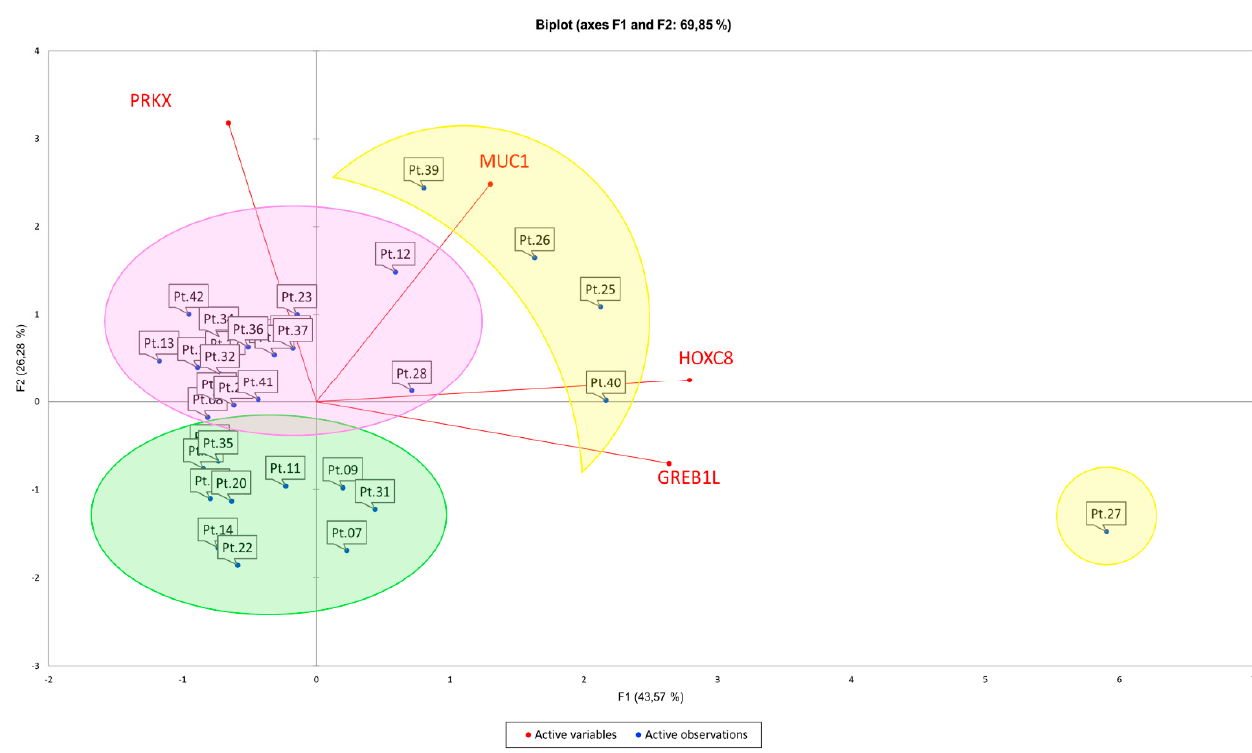
Figure 2. PCA on MRKH patients’ gene expression data. Graphical illustration of the 3 clusters retrieved from PCA. Cluster 1 (purple circle) contains 66.6% of MRKH type I, cluster 2 (green circle) includes 63.6% of MRKH type II, and cluster 3 (yellow circle) encompasses 5 outliers.